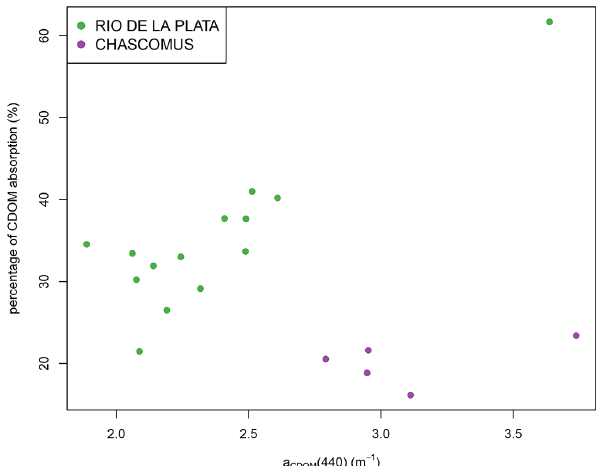
Figure 7. Percentage of CDOM absorption as a function of a CDOM (440). a CDOM was only measured during two